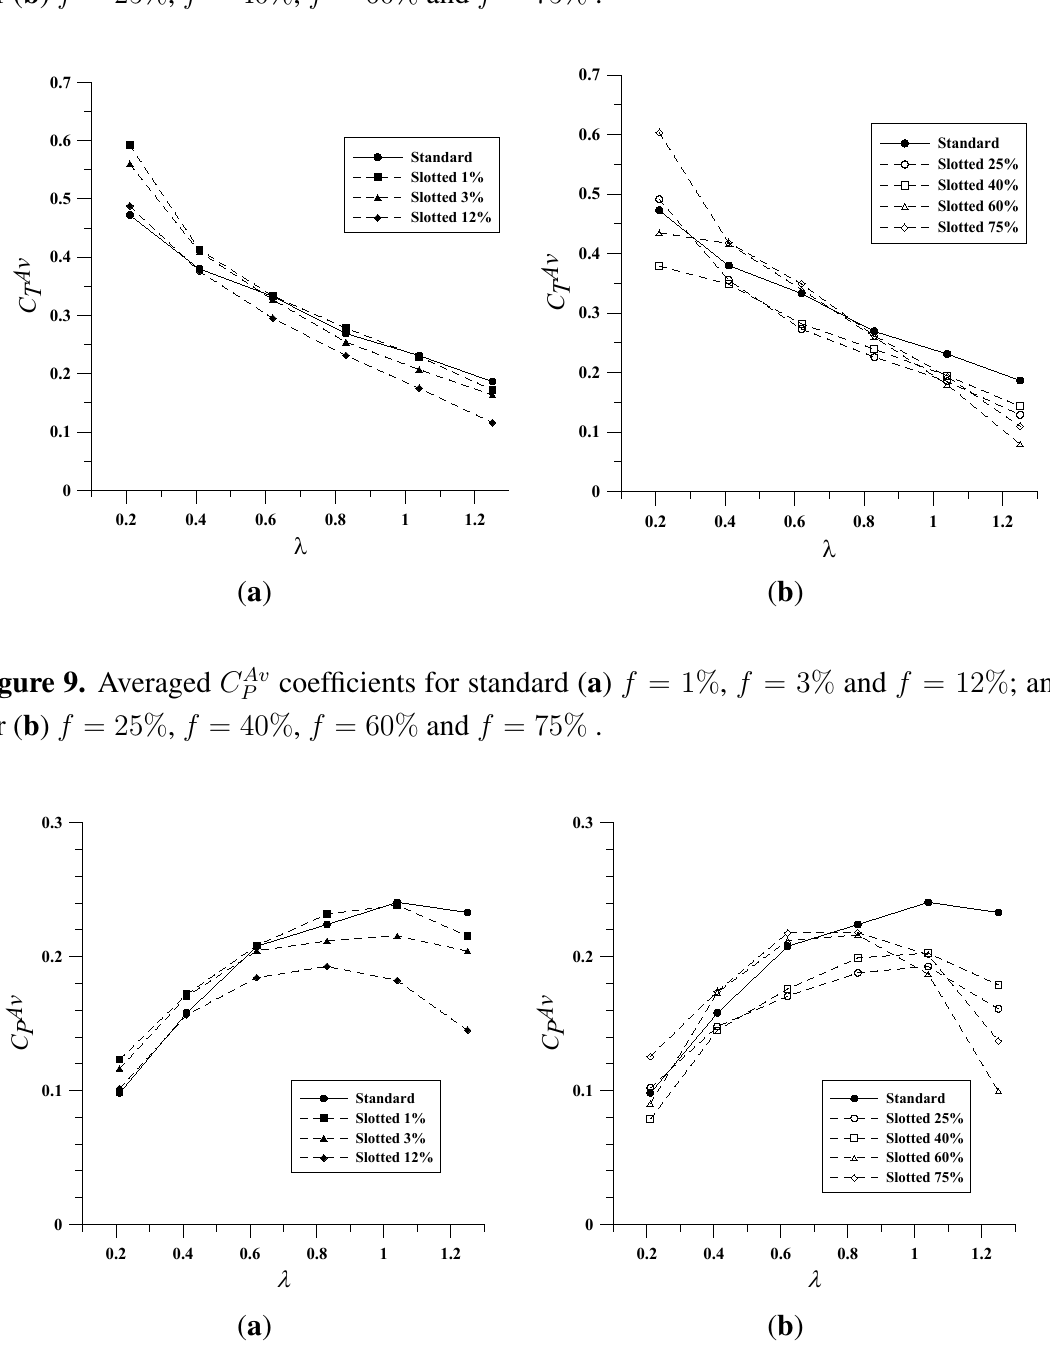
Figure 8. Averaged C Av coefficients for standard ( a ) f = 1% , f = 3% and f = 12% ; and T for ( b ) f = 25% , f = 40% , f = 60% and f = 75% .